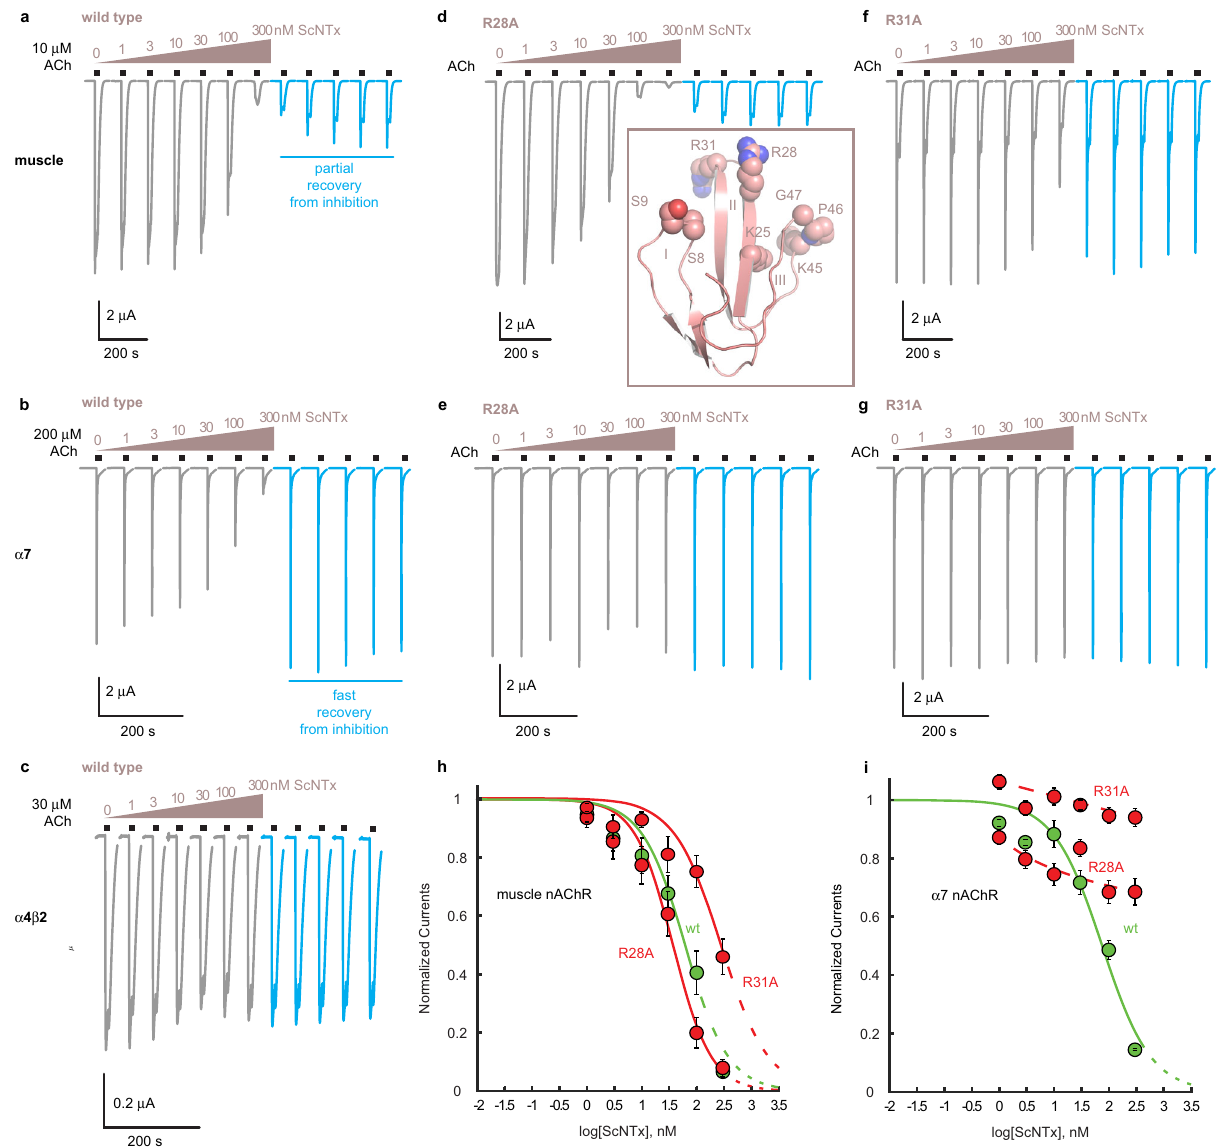
Fig. 4 | Pharmacological characterization of ScNtx. a – g Electrophysiological recordingson Xenopuslaevis oocytesexpressingdifferentsubtypesofnAChRs:the adult muscle-type nAChR, the neuronal α 7 nAChR and the neuronal α 4 β 2 nAChR. Horizontal bars indicate duration of acetylcholine application. Increasing con- centrations of ScNtx or mutant ScNtx (R28A or R31A) were applied as indicated in salmon. Traces in salmon indicate co-application of acetylcholine (at a concentra- tion near the EC50) and (mutant) ScNtx. Blue traces indicate application of